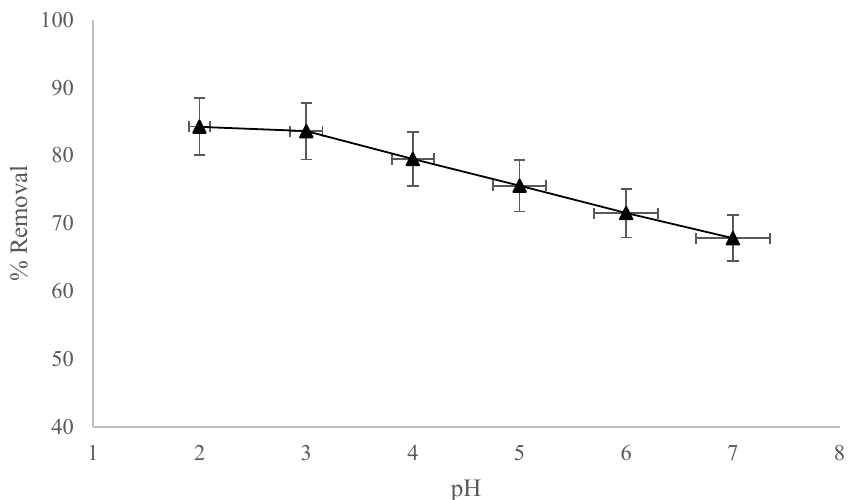
Figure 6. Effect of pH on Cr (VI) biosorption by CMPVL.